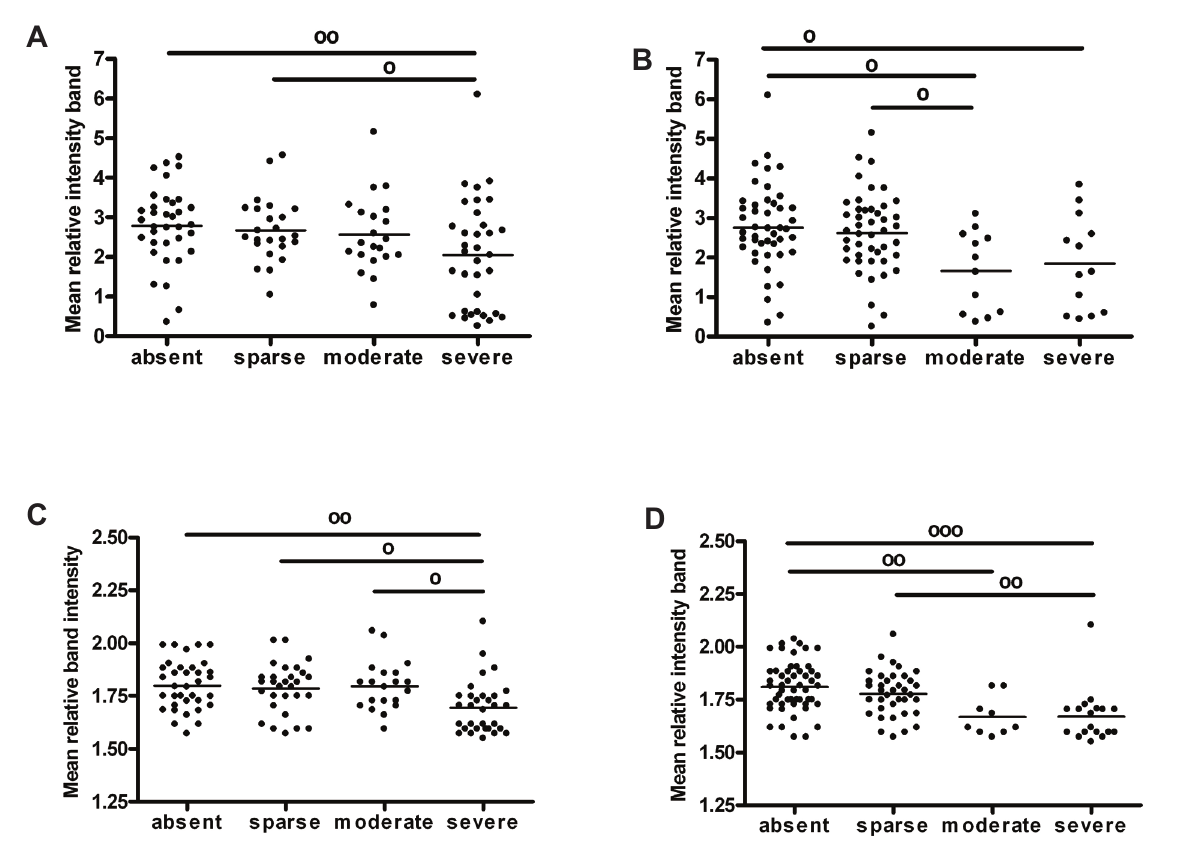
Figure 3. Correlates between synaptic markers and AD neuropathological features. ( A ) ratio phospho/totalCaMKII level with plaques scores in BA9, ( B ) ratio phospho/totalCaMKII with plaques scores in BA9, ( C ) phosphoCaMKII with plaques scores in BA40 and ( D ) phosphoCaMKII with tangles scores in BA40. Scatter plots represent values and bars the mean for each group. º (p<0.05), ºº (p<0.01) and ººº (p<0.001).